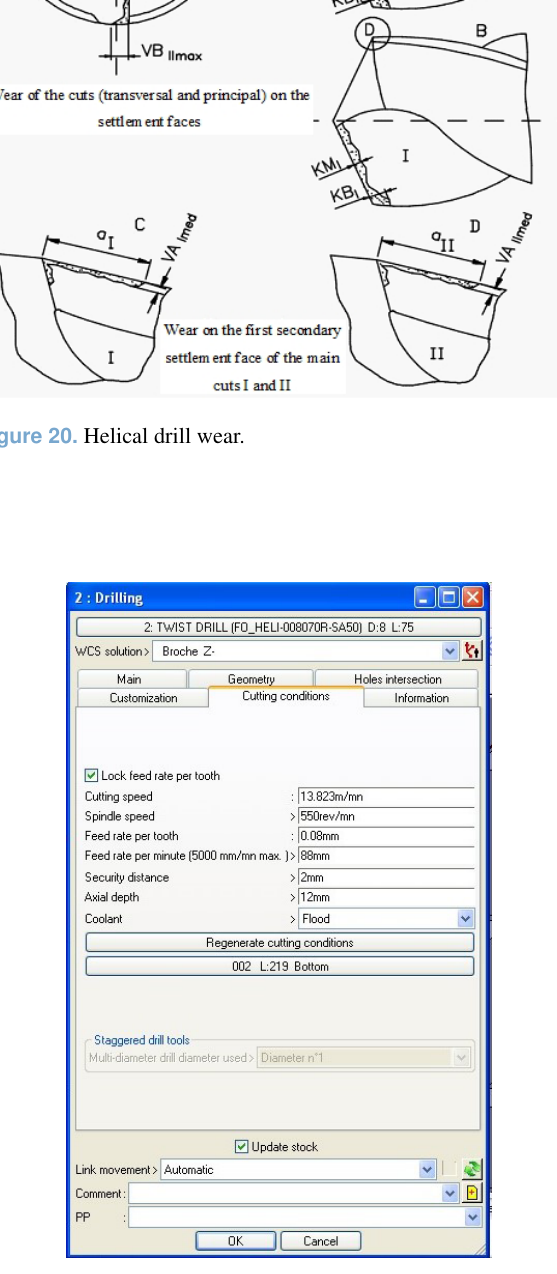
Figure 21. Setting the drilling parameters.